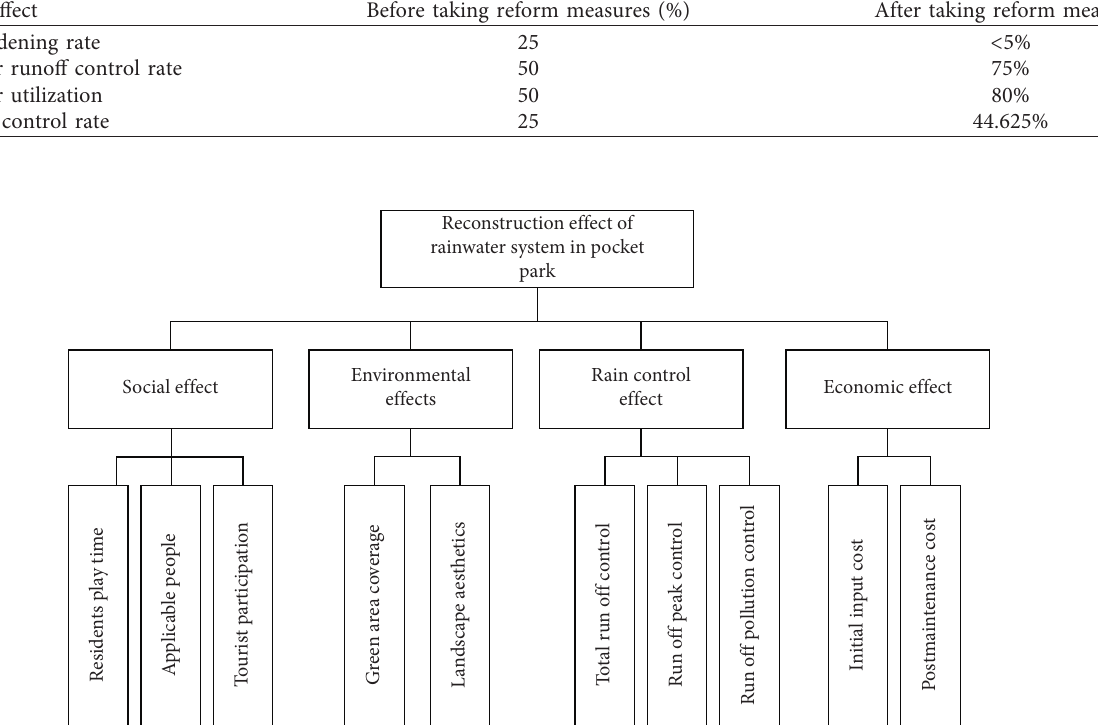
Figure 2: Hierarchical structure system diagram of the transformation effect of the pocket park rainwater system. Table 8: Standard table of the index scale.